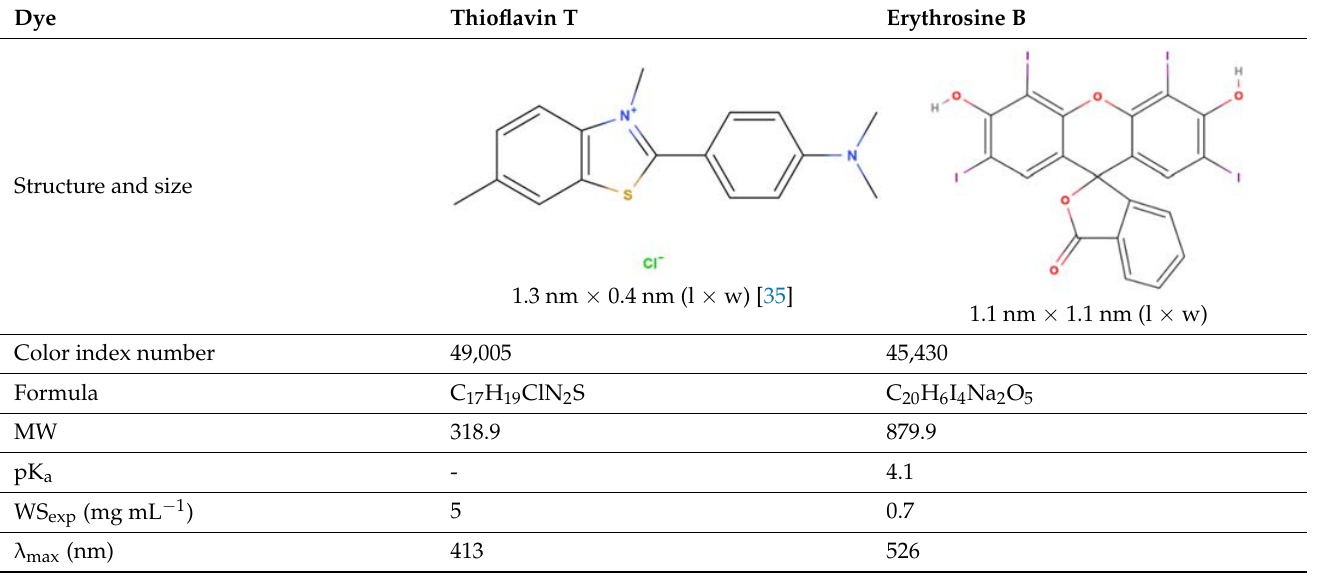
Table 1. Selected physicochemical properties and molecular structure of TT and EB.